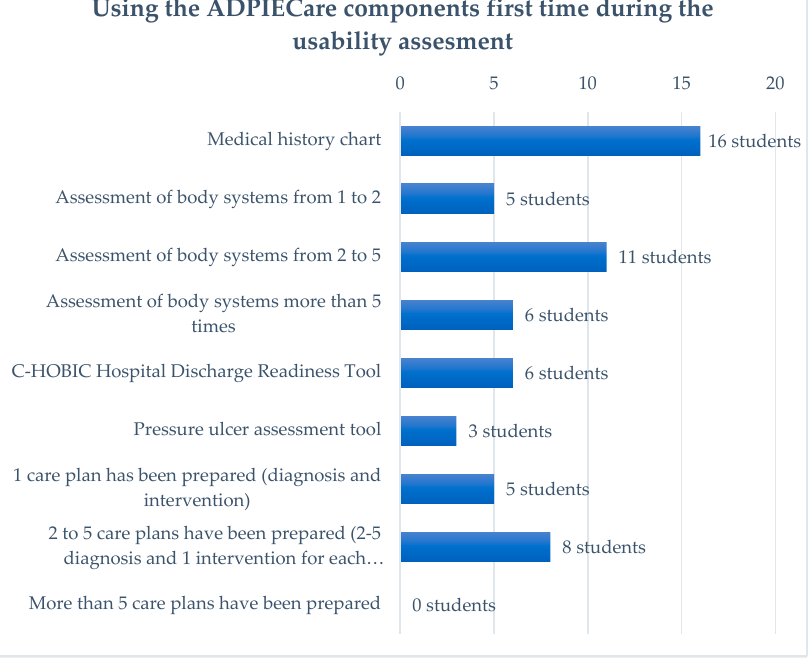
Figure 10. The use of individual components of the ADPIECare system by the surveyed students. Another cross-section of information about the surveyed persons concerns the goal of the use of the application during its first use. The data presented in the figure above demonstrate that users most frequently filled out the medical history chart. “Assessment